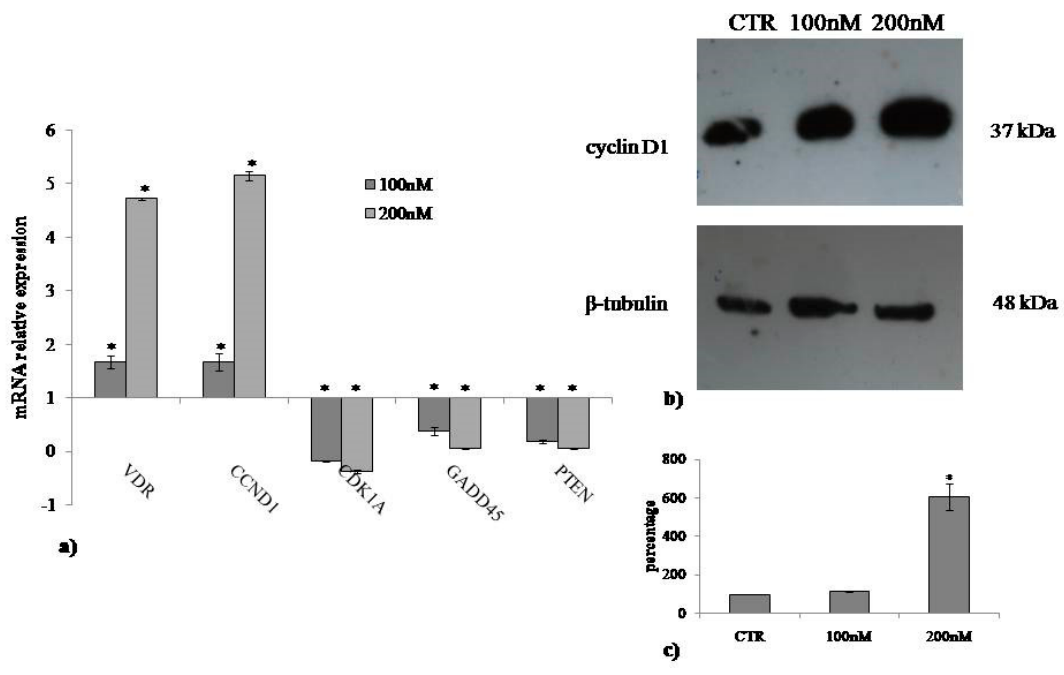
Figure 4. E ff ect of VD3 on cyclin D1. ( a ) Gene expression evaluated by RT-PCR; ( b ) immunoblotting, with the position of the 37 kDa protein for cyclin D1 and 48 kDa for β -tubulin indicated in relation to the position of molecular size standards; ( c ) area density evaluated by densitometry scanning and analyzed with ImageJ program. Values of cyclin D1, normalized with β -tubulin, are expressed as fold changes with respect to the control sample, which is considered equal to 1. Significance, * p < 0.001 versus control sample.